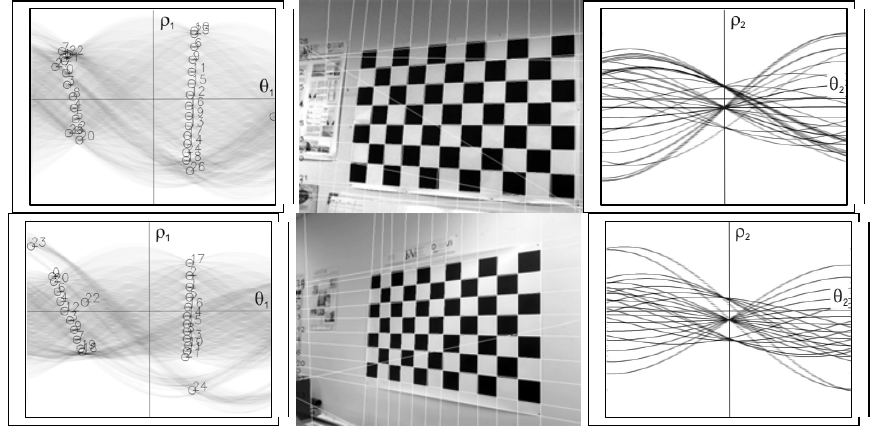
Figure 7. Detection of the set of lines. Maximums of the Hough transform (left column), images with the lines detected (middle column) and the second Hough transform (right